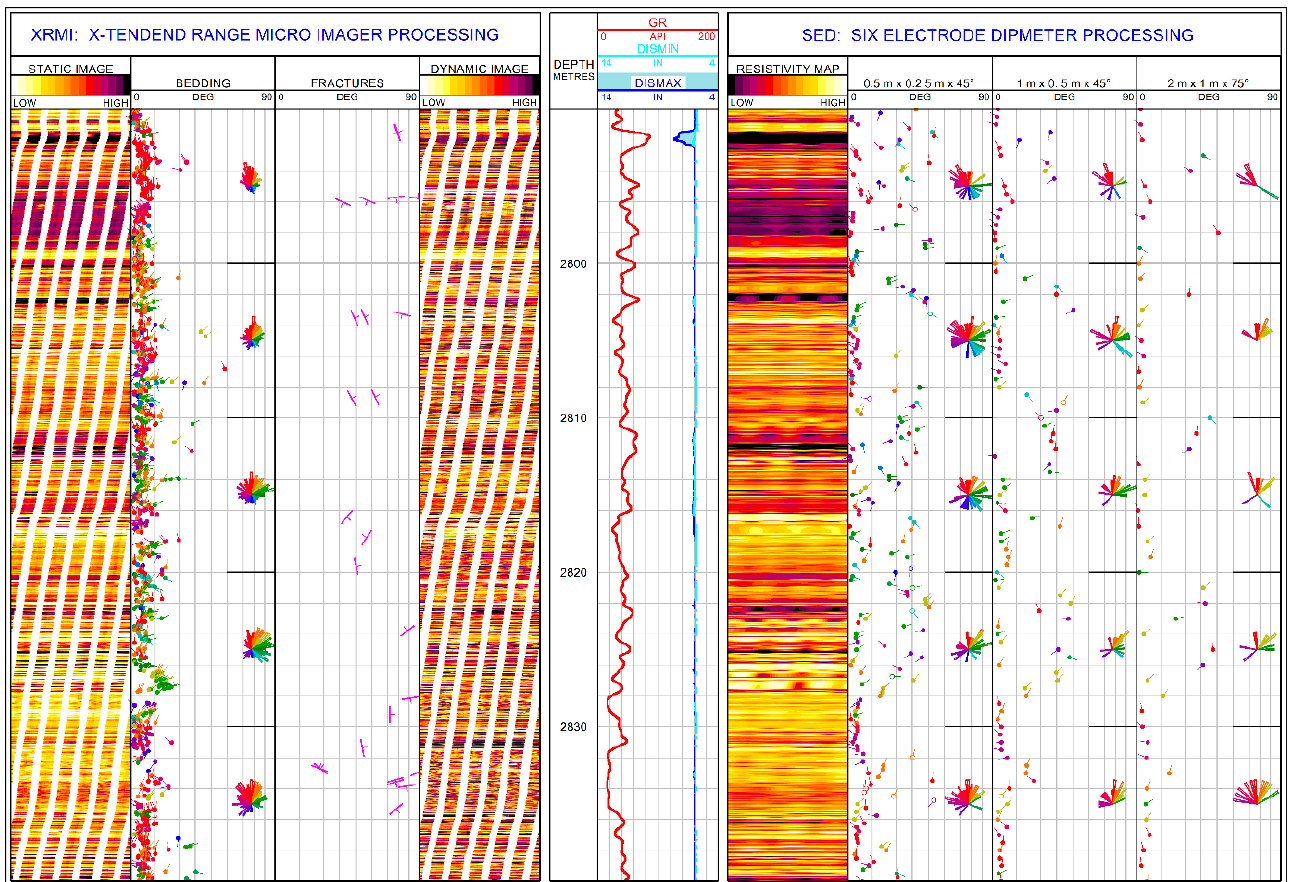
Figure 11. Sample of XRMI (left) and SED (right) plots after processing; GT ‐ 1, T2, Muschelkalk, 2795–2865 m, carbonates; explanations the same as in Figure 10.